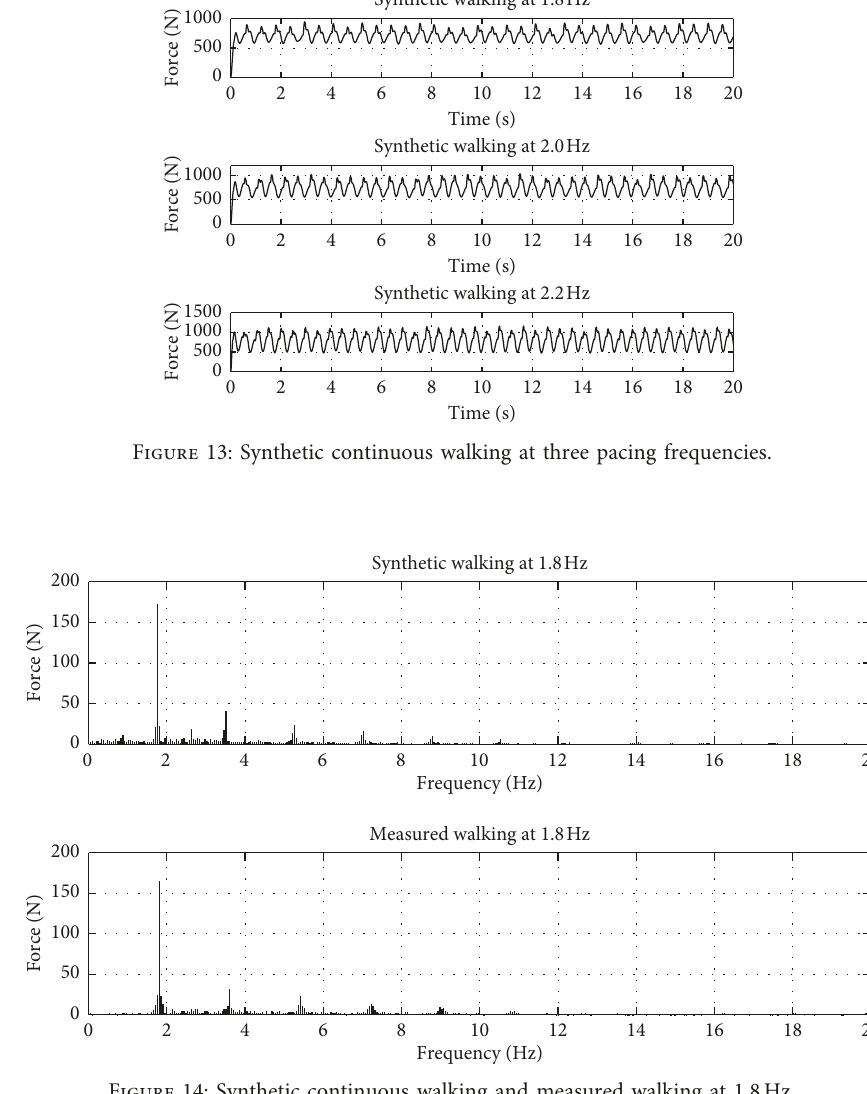
Figure 14: Synthetic continuous walking and measured walking at